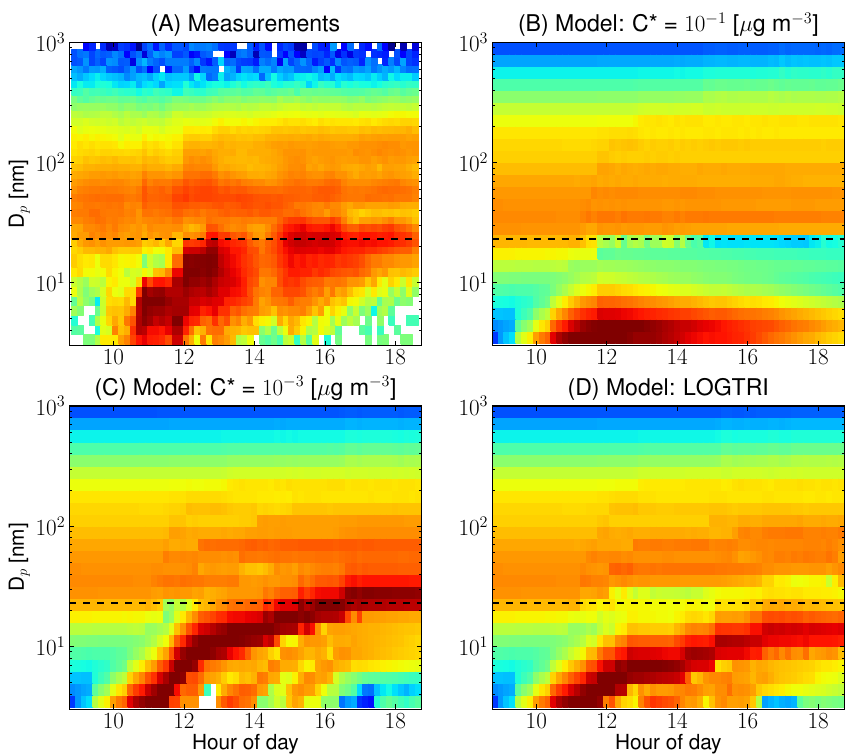
Fig. 3. Comparison of model-predicted growth of nucleated aerosol to measurements on 10 April 2007 in Hyyti¨al¨a. Panel (a) is the measured dN / d log D p timeseries. Panels (b–d) are the simulated dN / d log D p timeseries with condensing volatility distributions of C ∗ = 10 − 1 , C ∗ = 10 − 3 and LOGTRI, respectively. Surface tension was 0.025Nm − 1 , the accommodation coefficient was 1, the pre-existing SOA had C ∗ = 10 − 5 µgm − 3 and SOA does not partition into sulfate and water for these simulations. For comparison between the modelled cases and the measurements, the black dashed horizontal line in each figure denotes maximum diameter of the nucleation mode measured to during the